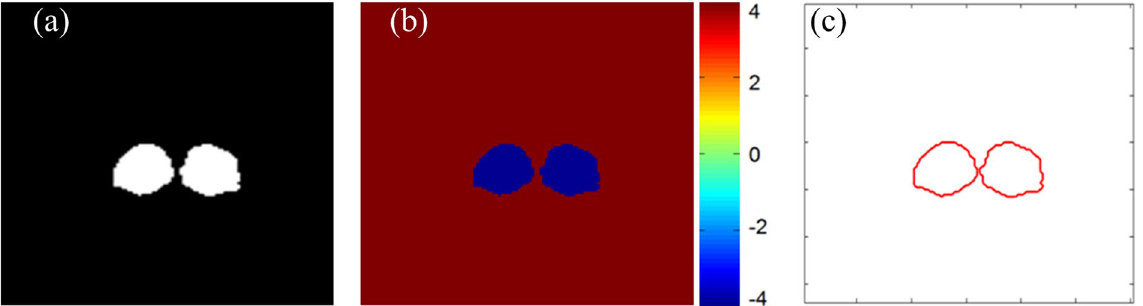
Figure 4. 2D slice of an example of the shape modeling using the level-set method. ( a ) Manually segmented shape, ( b ) Level set function (LSF), ( c ) Zeros level